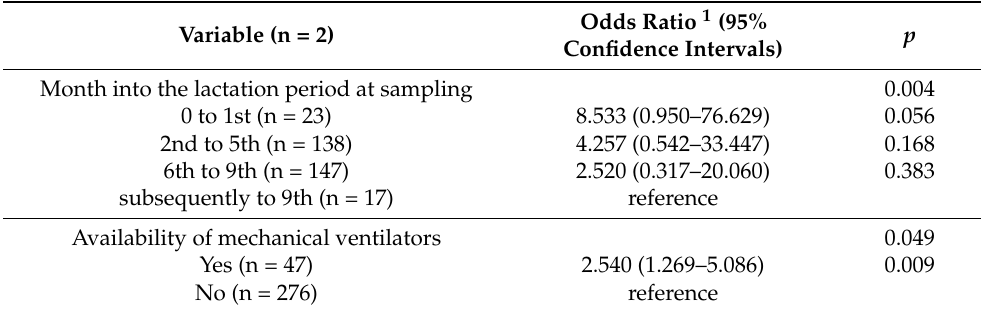
Table 7. Results of multivariable analysis for increased bacterial counts (> 1.5 × 10 3 cells mL − 1 ) in the bulk-tank milk of 325 sheep flocks in Greece (mixed effects logistic regression).